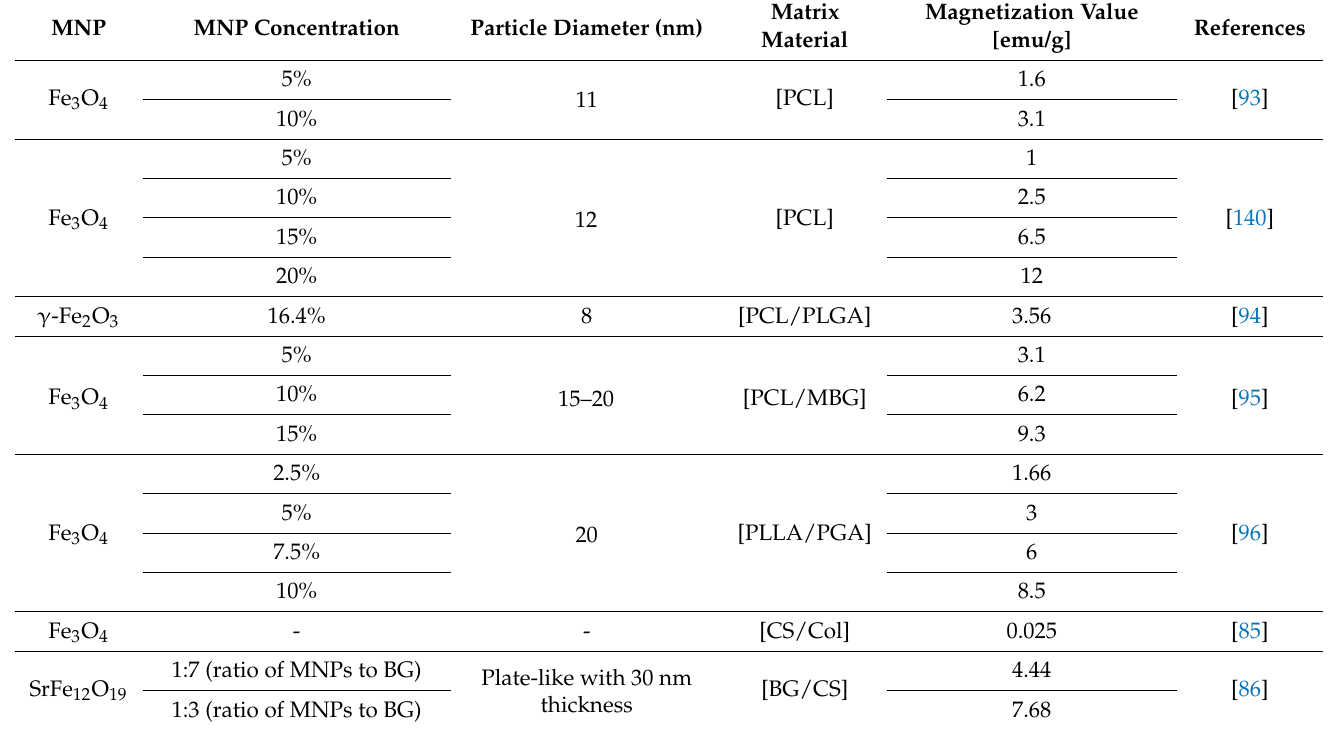
Table 3. Concentration, particle diameter, and magnetization values of MNPs incorporated in polymeric or composite